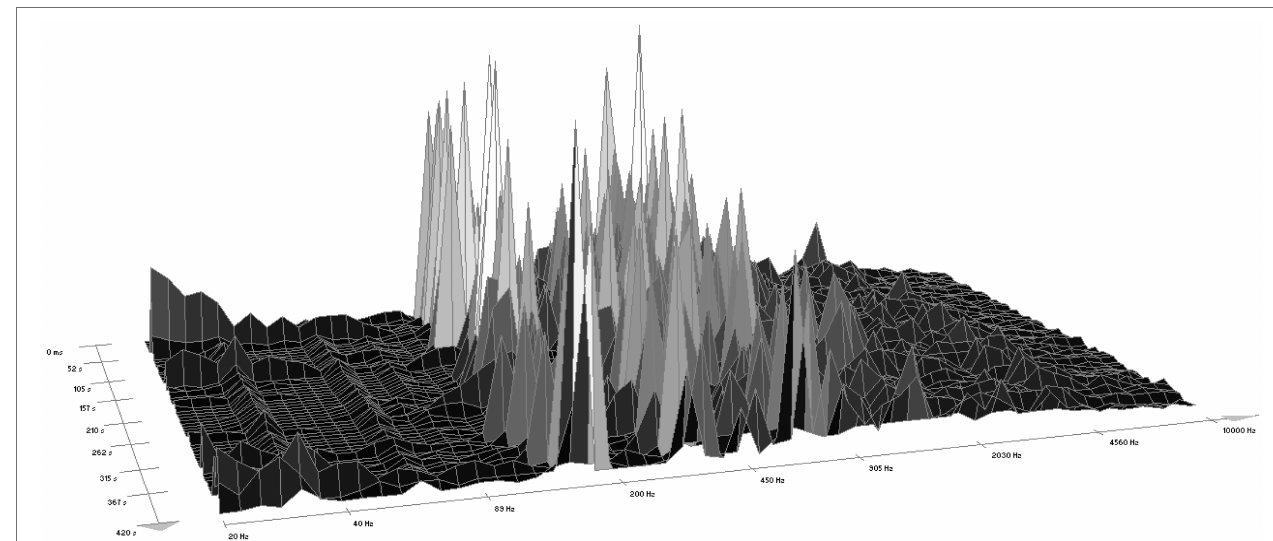
FIGURE 1 | A spectrogram of the sound of a chainsaw (according to WaveLab